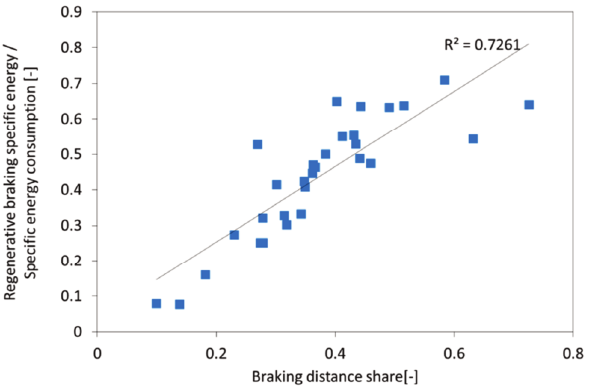
Fig. 5. Relation between the braking distance share and the share of the regenerative braking specific energy